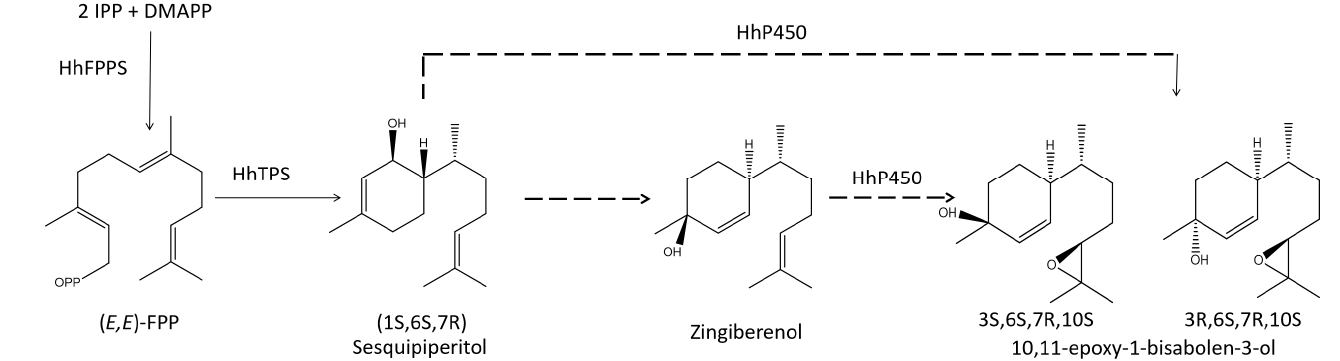
Figure 1. Proposed biosynthetic pathway of the aggregation pheromone in H. halys.